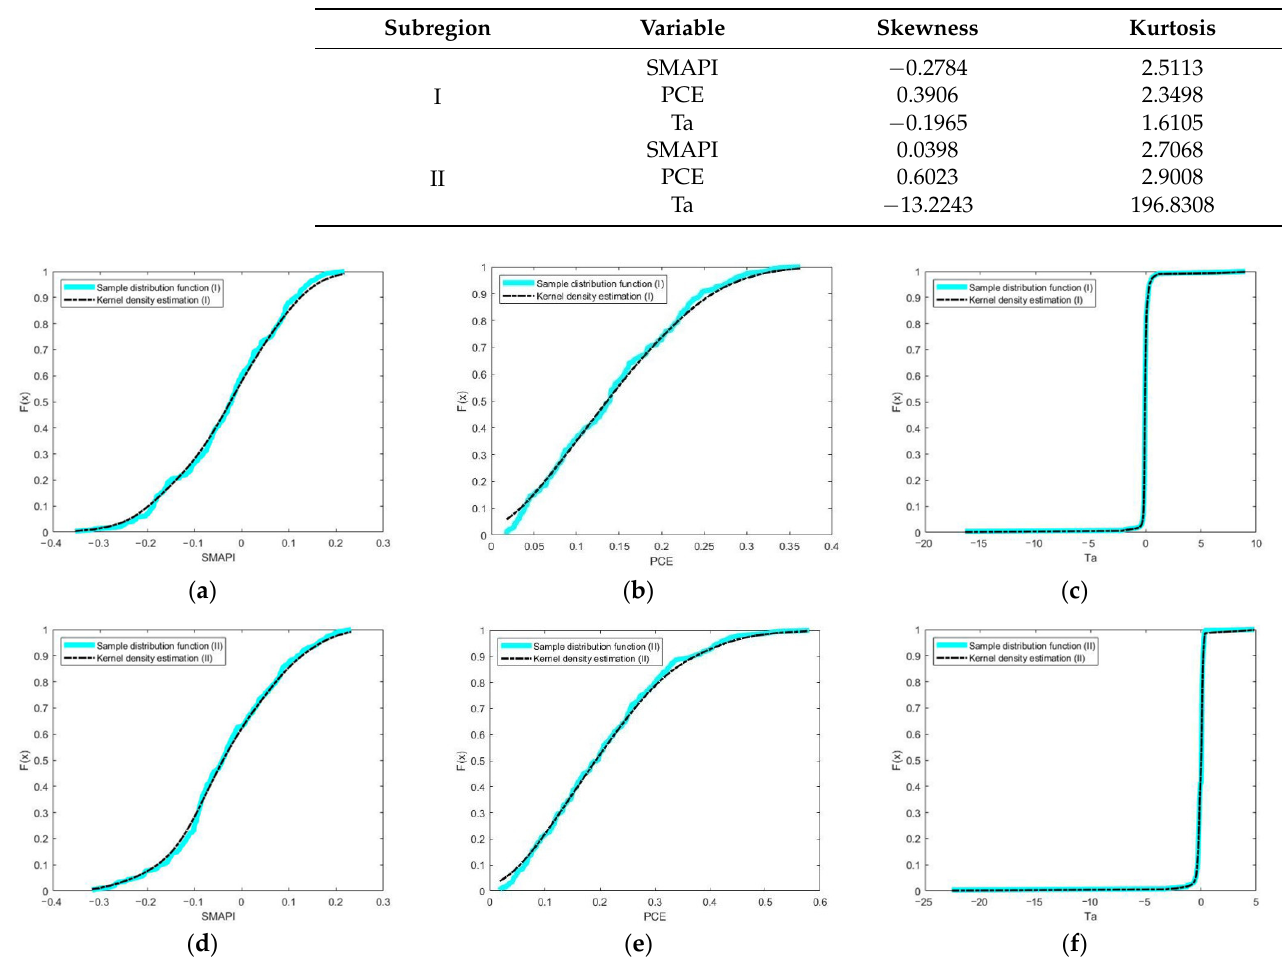
Figure 6. Kernel distribution estimations and empirical distribution functions of SMAPI ( a ), PCE ( b ), and Ta ( c ) in Subregion I as well as SMAPI ( d ), PCE ( e ), and Ta ( f ) in Subregion II.